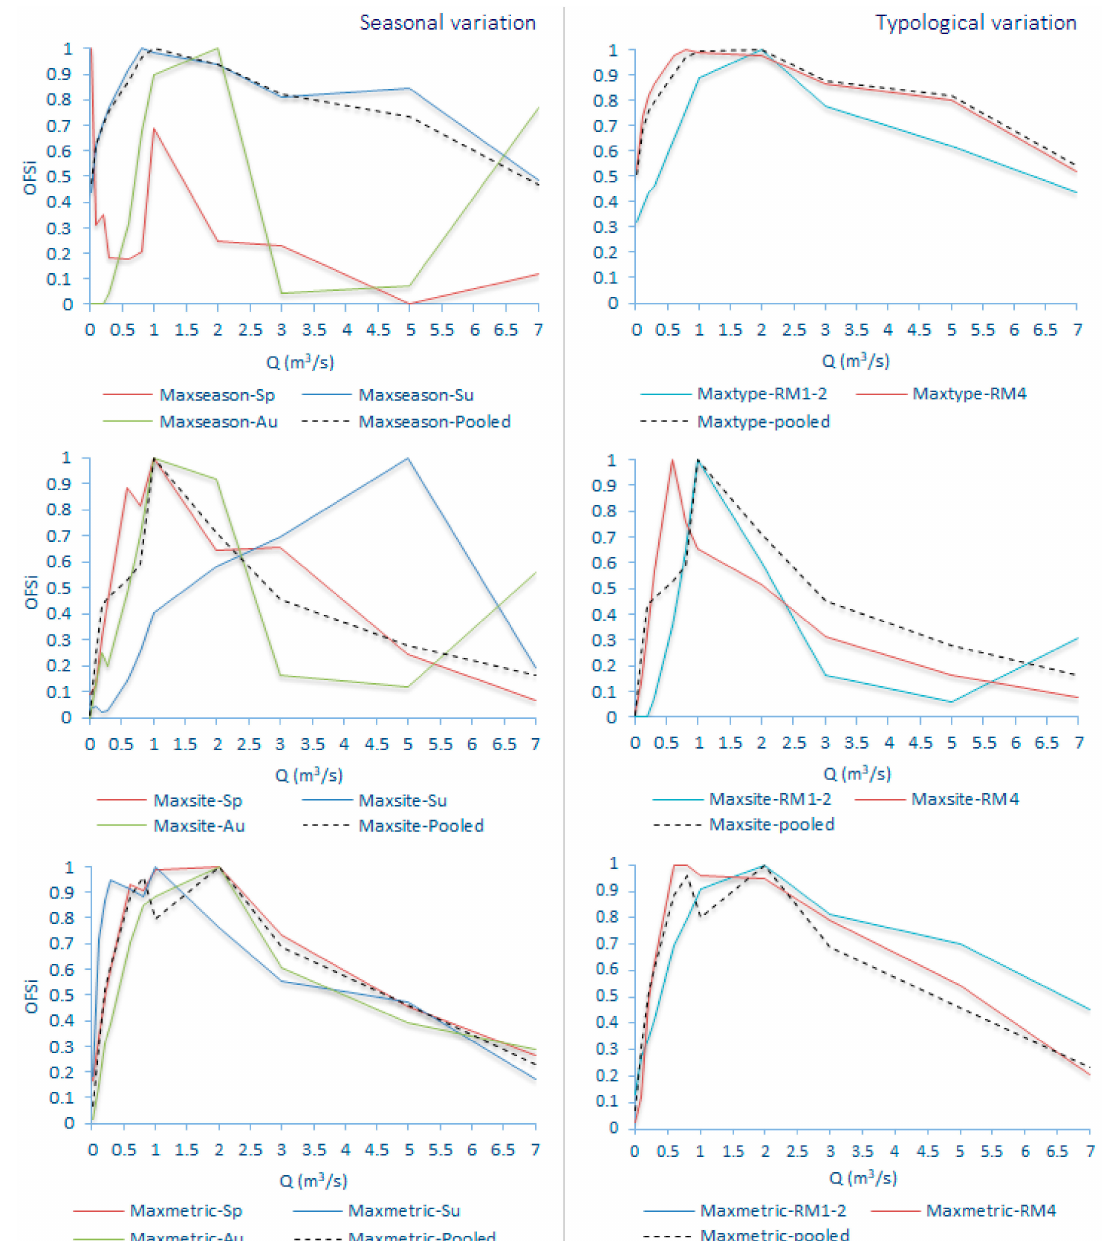
Figure 6. Seasonal and typological variation in the selection of the OFS for the Parapeiros reach within the various habitat-suitability calculation-normalization options (Sp: Spring; Su: Summer; Au: